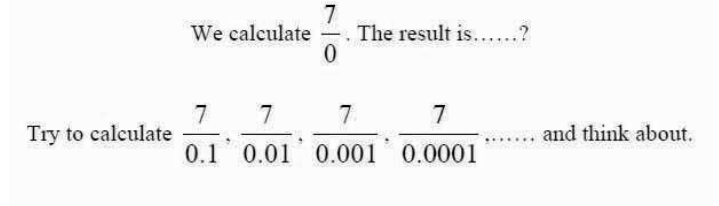
Figure 6. Thinking about the concept of in (cid:222) nite and in (cid:222) nitessimal. Source: personal